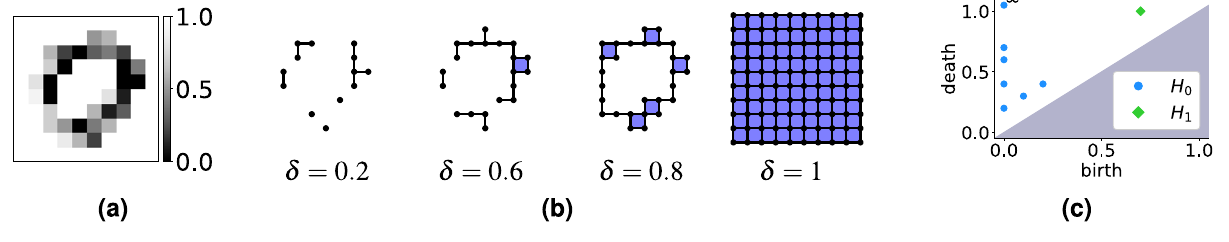
Figure 2. Cubical levelset filtration of a greyscale image. ( a ) Example greyscale image with pixel intensity values between 0 (black) and 1 (white), as in the colour bar. (b) Some ordered steps of the cubical levelset filtration of the image in ( a ). As the threshold parameter δ increases from 0 to 1, pixels (of intensity lower than δ ) are included as points (0-cubes), with two adjacent pixels joined by edges (1-cubes), and 4 adjacent pixels joined by squares (2-cubes). Note the ring we see in the image is captured by the third step of the filtration shown. ( c ) Persistence diagram for H 0 and H 1 of the image ( a ) with respect to the levelset filtration described in ( b ). The blue dots ( H 0 ) correspond to connected pieces, which ‘die’ as they join one another. The final connected piece never ‘dies’, so has infinite persistence (marked as ‘ ∞ ’). The green diamond ( H 1 ) corresponds to a loop ( b , panel 3) capturing the ring structure in the image ( a ). This loop disappears (‘dies’) as we add more pixels ( b , panel